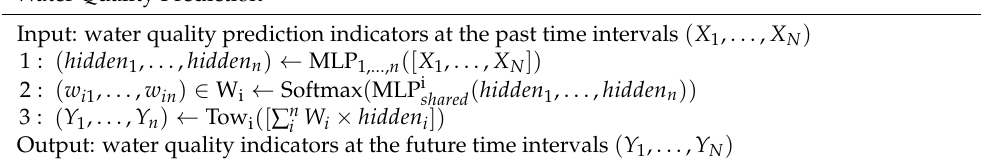
Algorithm 3: Multi-task Learning of Gating Parameter Sharing Structure for Multi-indicator Water Quality Prediction